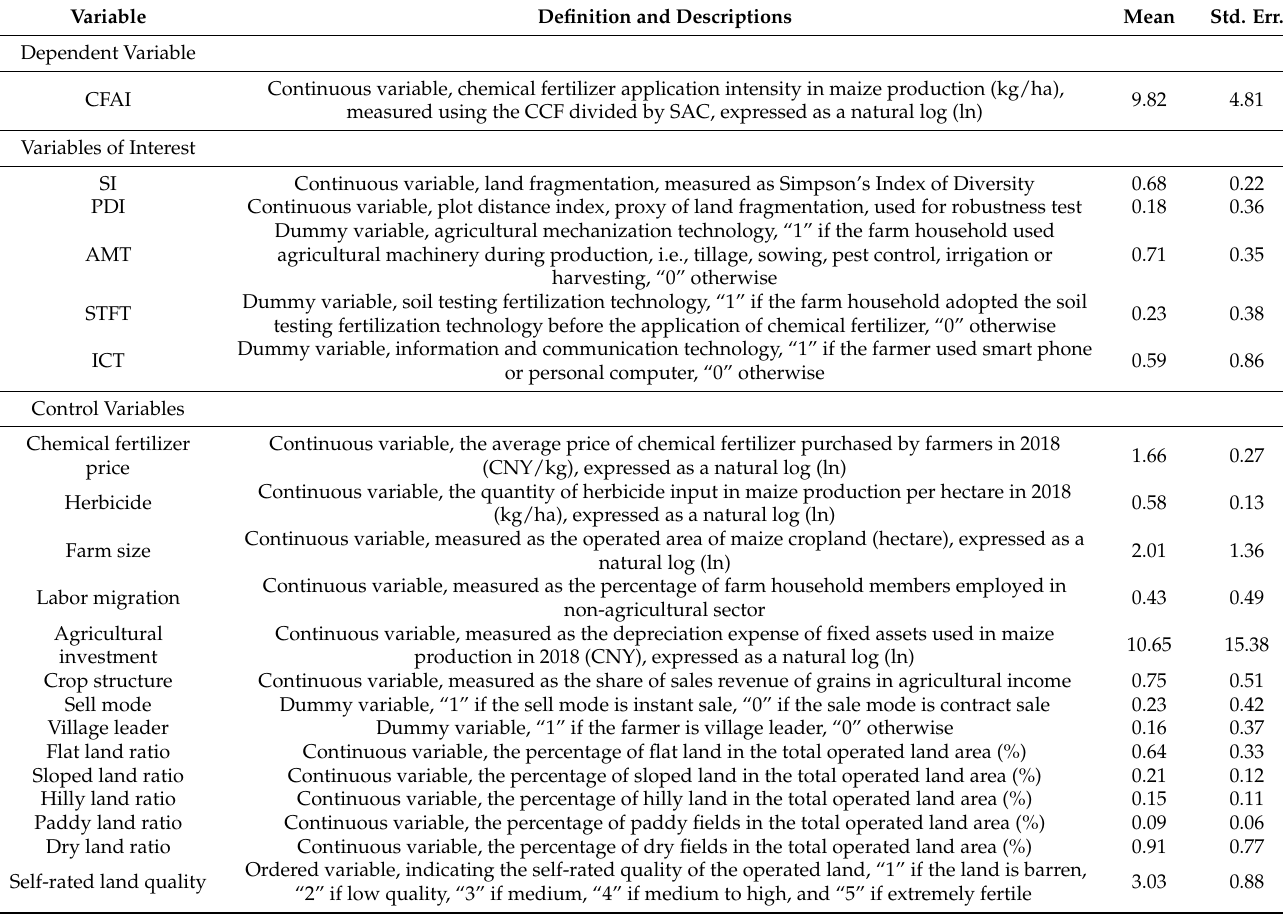
Table 2. List of variables and